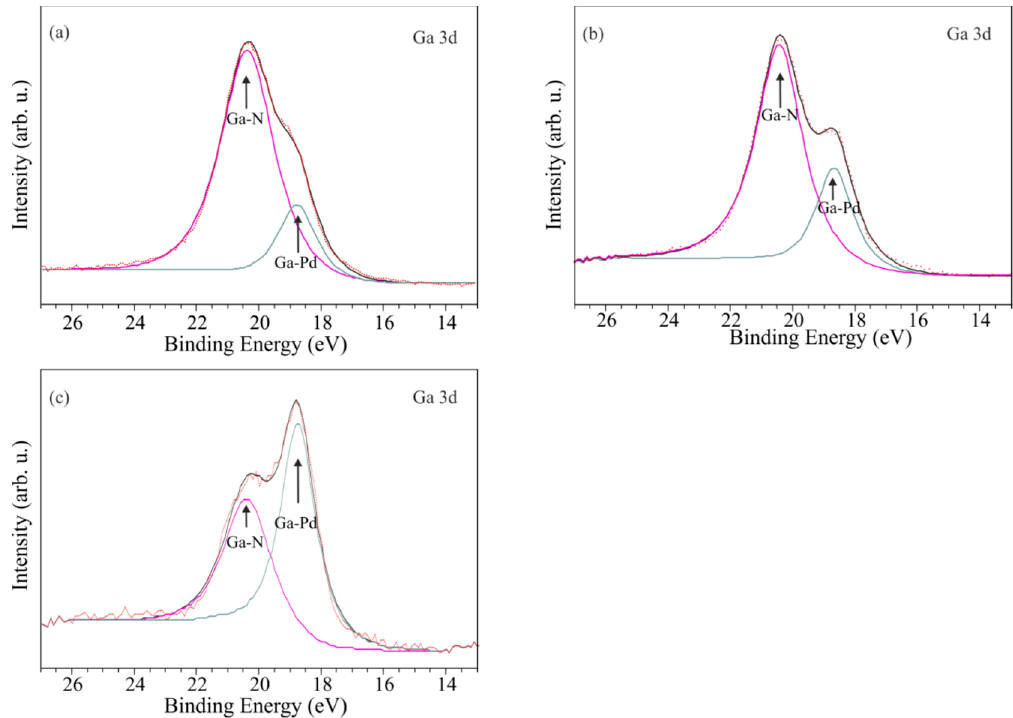
Figure 29. Ga-3d spectra for Pd on GaN(0001). ( a – c ) Subsequent cycles of Ni deposition and annealing of the system. Data previously published in [34]. Reprinted with permission from [34]. Copyright 2015 Springer Nature.